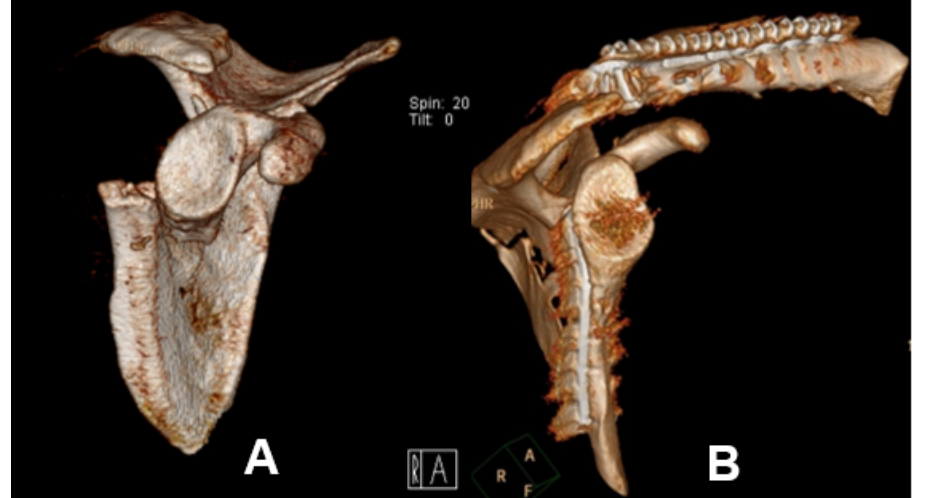
Figure 3. 3D reconstruction of CT imaging of displaced scapula body fracture classified according to